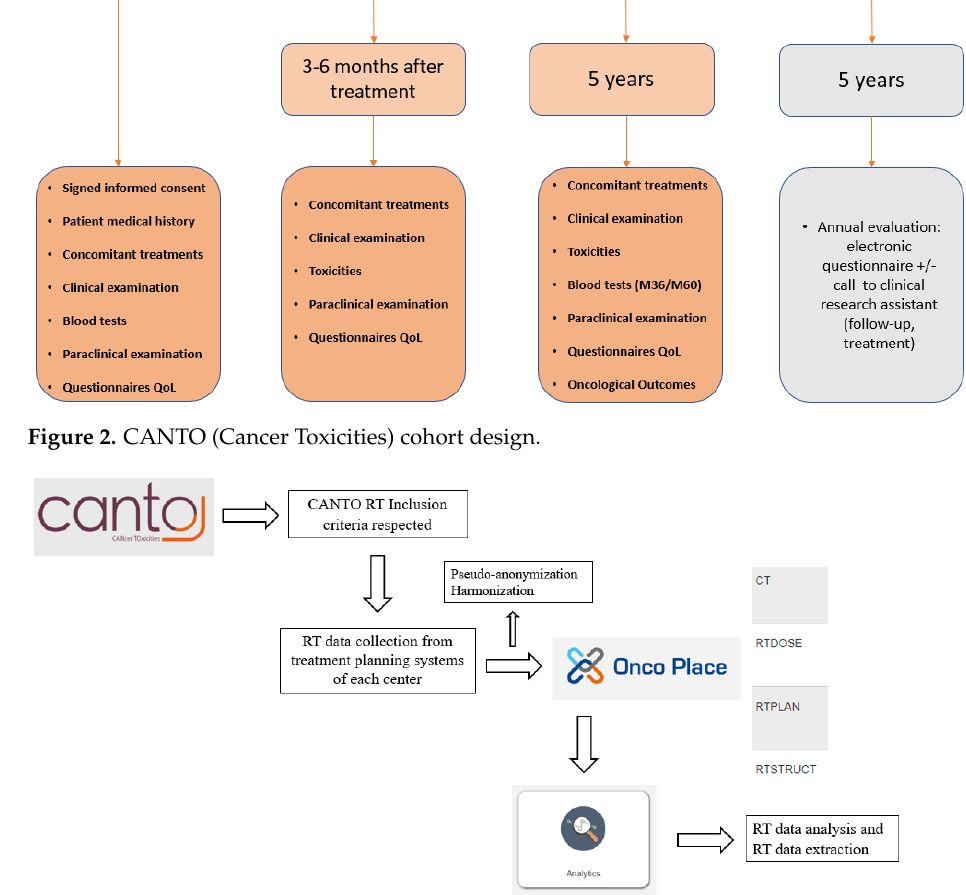
Figure 2. CANTO (Cancer Toxicities) cohort design.